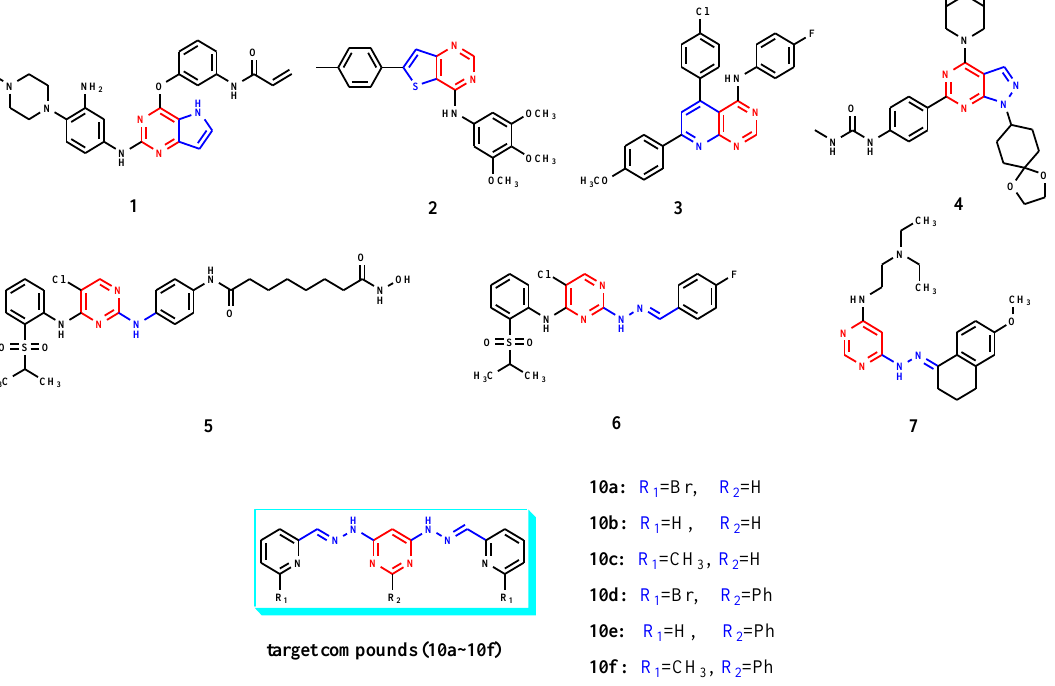
Figure 1. Representative examples of identified antitumor pyrimidine derivatives ( 1 – 7 ) and target compounds ( 10a – 10f ).